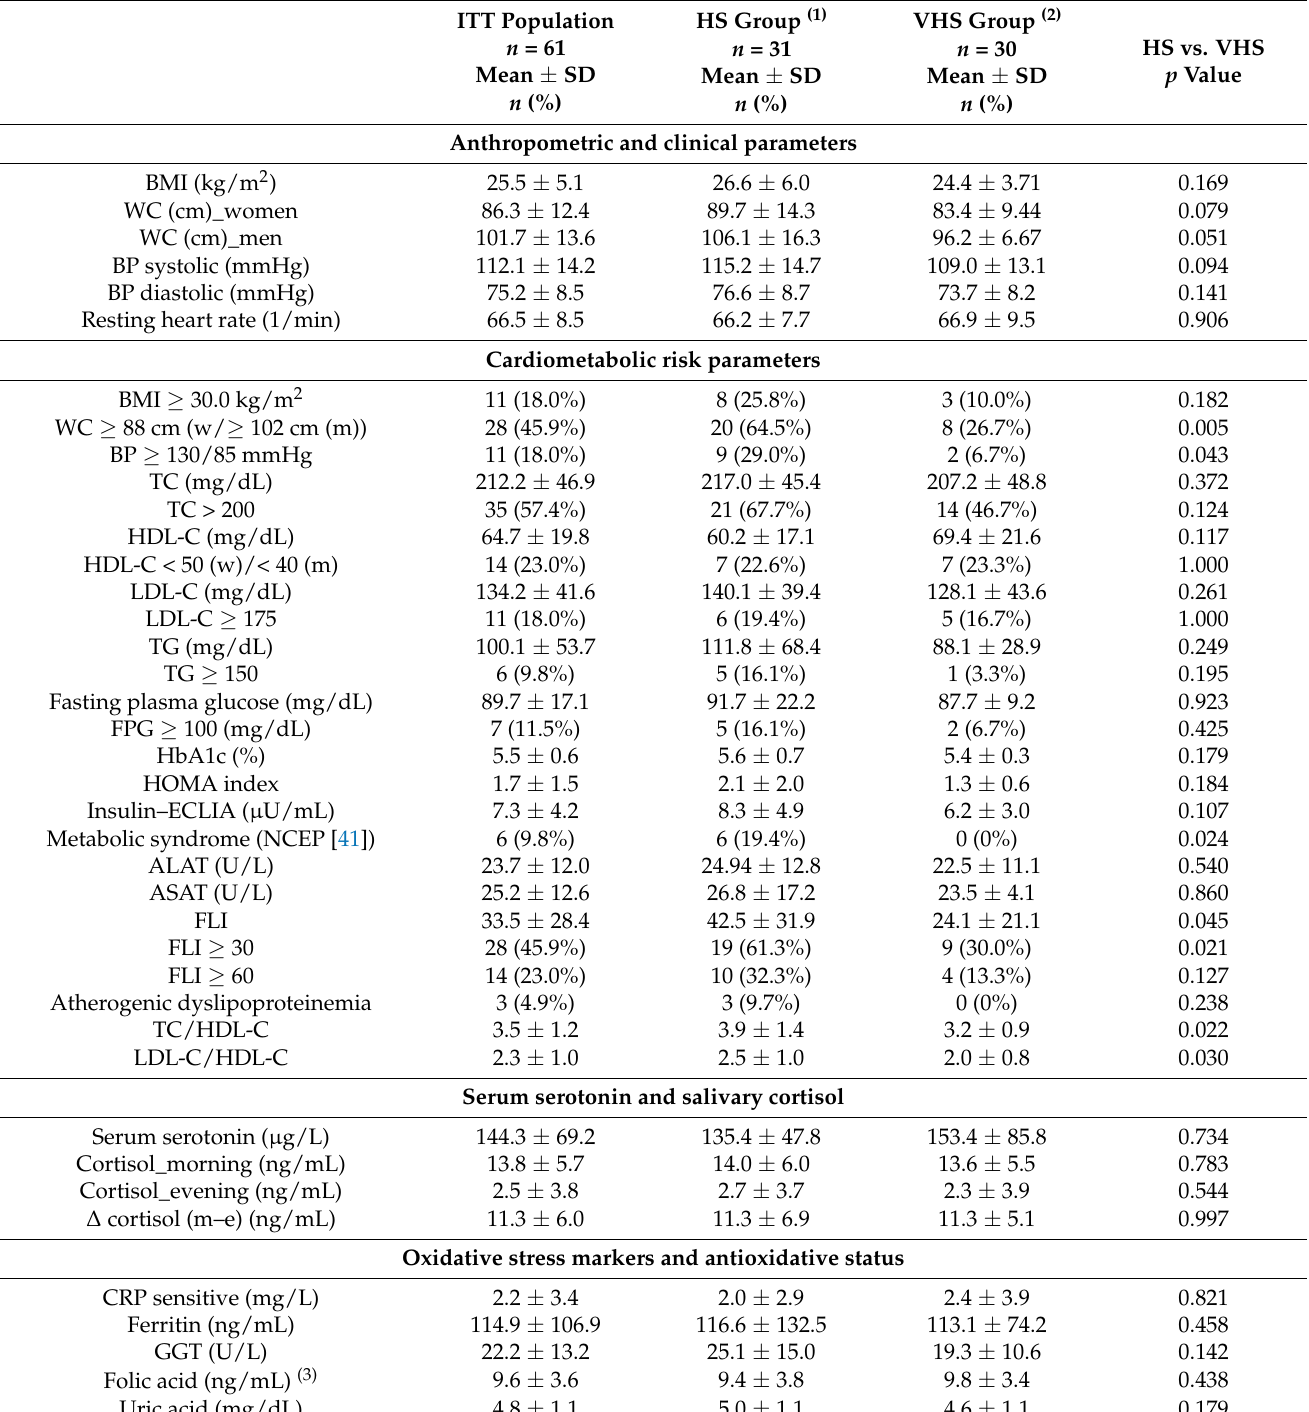
Table 2. Cardiometabolic risk of participants.